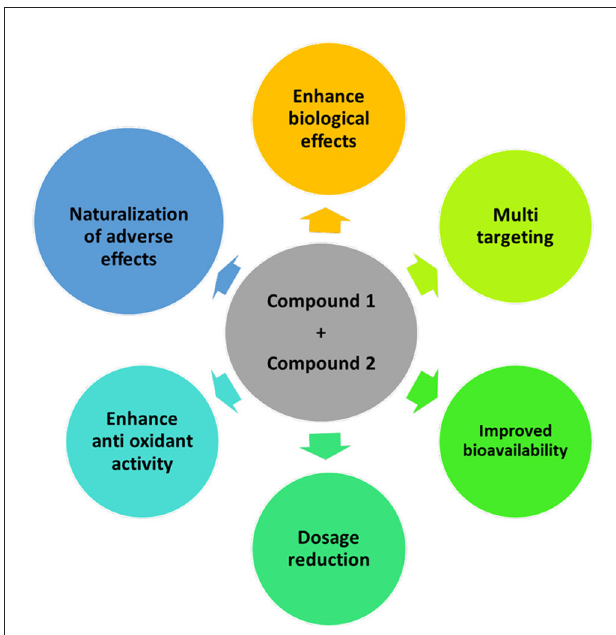
FIGURE3 Mechanism of synergism—improvement in antioxidant activity, bioavailability, and biological effects of compounds; reduction of the dosage of individual compounds; act on new targets or multiple targets, or multiple pathways; naturalization of the adverse effect of individual